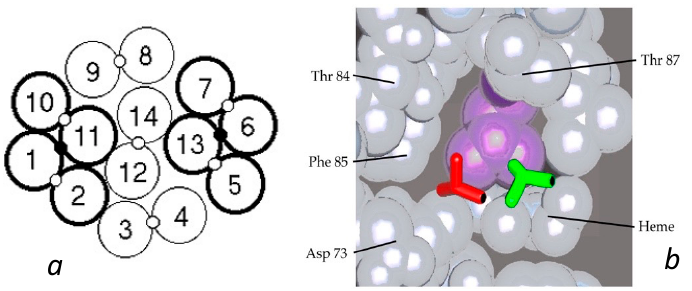
Figure 3. Interior new lateral contacts and polymer stability. ( a ) Cross section of the Carragher structure with the lateral contacts between the standard double strands shown as open circles between the 14 tetramers. By means of a small perturbation of that structure, an additional contact can be made as shown by the small black circle connecting strands 1 and 11, and 6 and 13 [9]. For convenience, such a cluster of two double strands is labelled a “quad strand”. ( b ) Comparison of the Val β 6 shown as a licorice drawing docked into the acceptor pocket. The new contact (green) is only slightly displaced from that found in the X-ray structure of the double strands (red). The purple amino acid is Leu β 88.